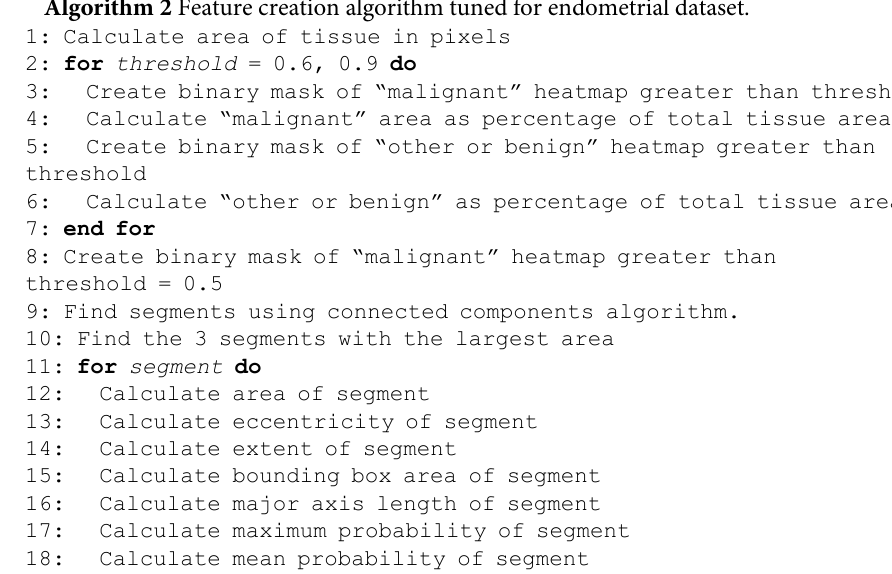
Algorithm 2 Feature creation algorithm tuned for endometrial